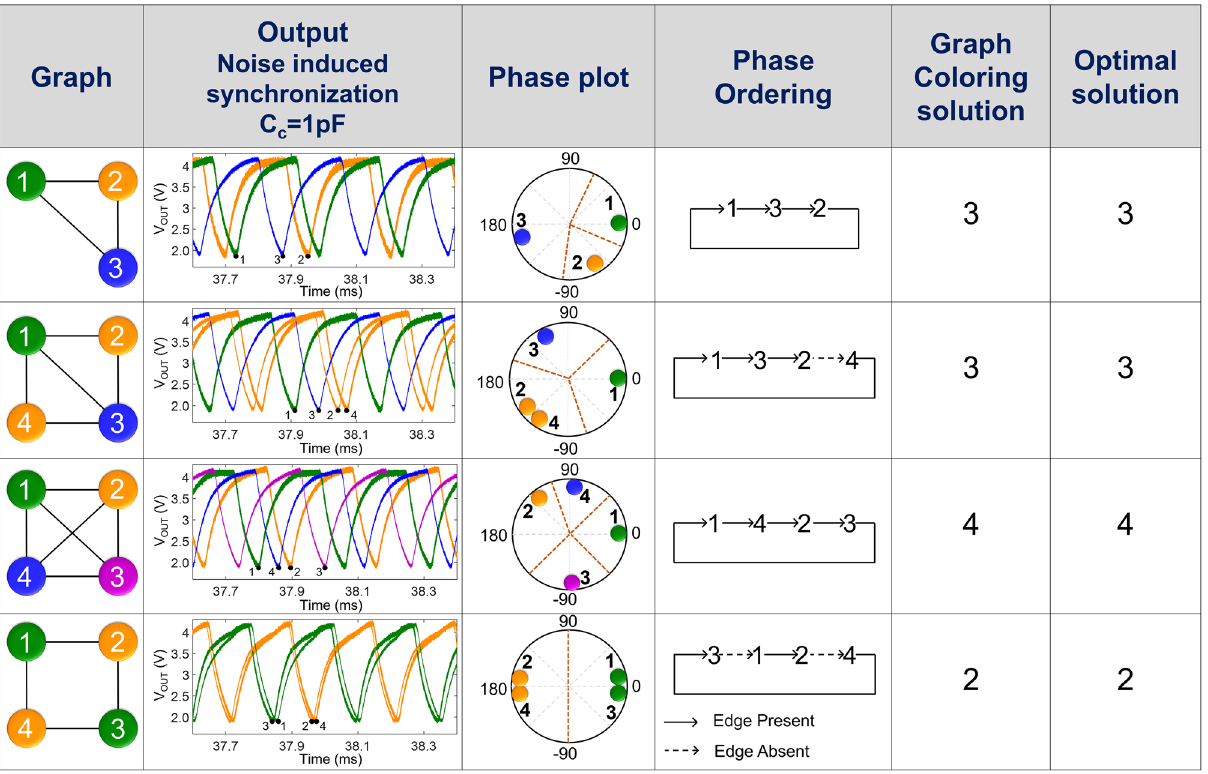
Figure 4. Experimentally observed noise induced synchronization, resulting phase plot and observed graph coloring solutions for various coupled oscillator networks (C C = 1pF).